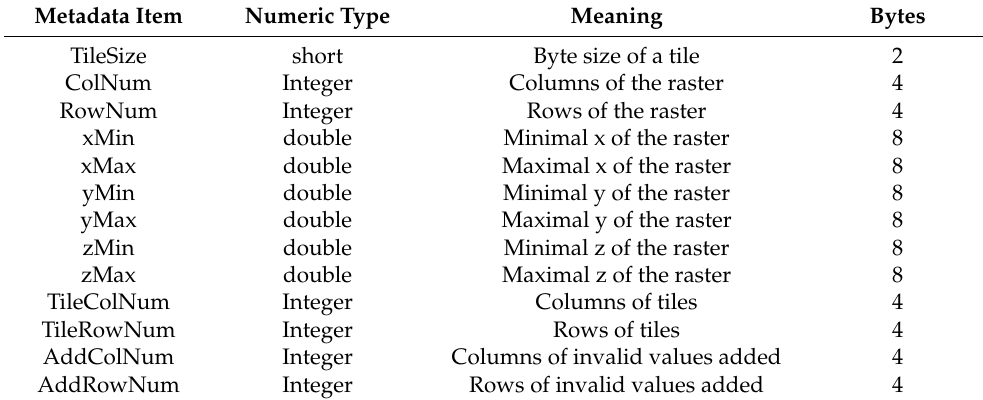
Table 1. Metadata